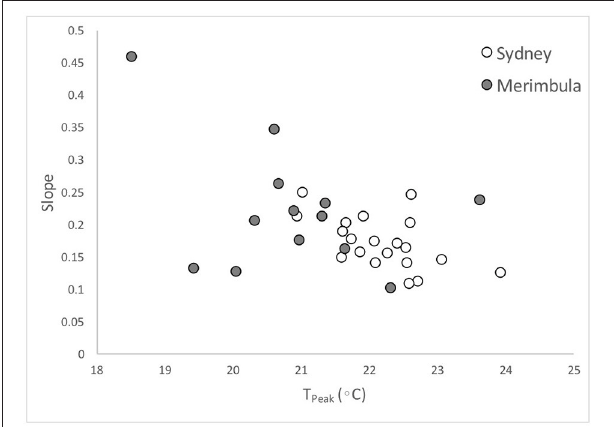
FIGURE 4 | Relationship between predicted T peak and slope of temperature-drop, fish abundance drop curves, for the 20 species. Each point is average of all values available for each species. Not all species occurred in